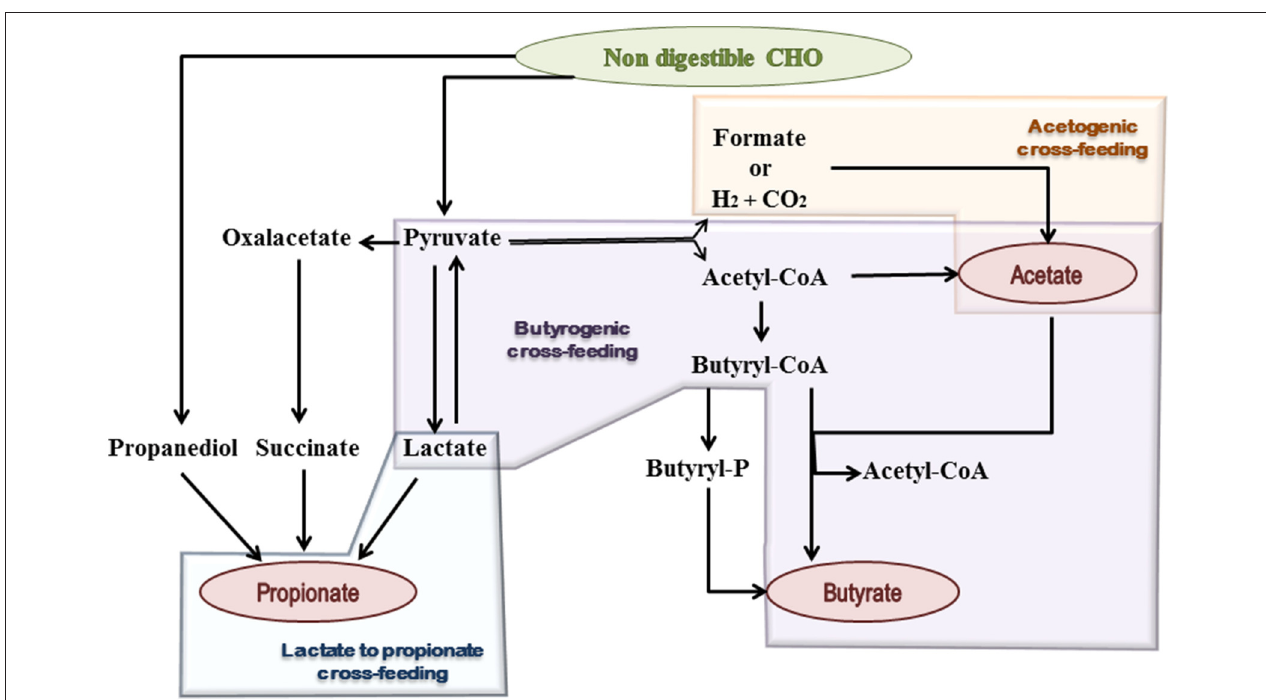
FIGURE 1 | Schematic representation of microbial metabolic pathways and cross-feeding mechanisms, contributing to SCFA formation in the human gut. Shaded geometric shapes summarize routes of formation for each of the three main SCFA: acetate, propionate, and